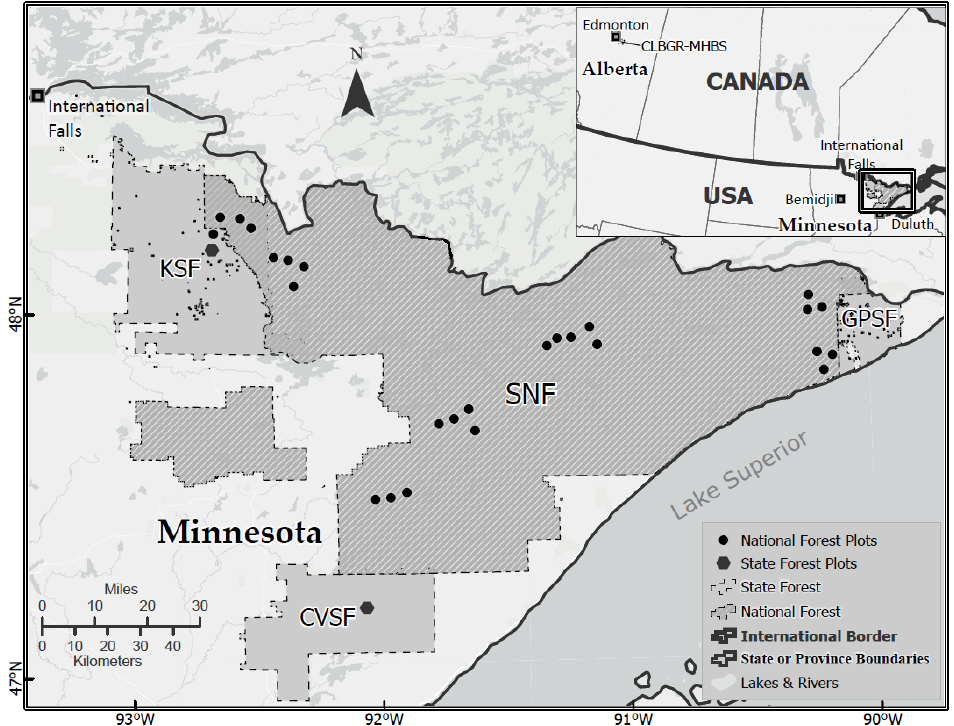
Figure 1. Study areas in Minnesota (Hodson 1977; inset + main map) and Alberta (Roland 2005; inset only). The National Forest sample sites (dots) indicate the clustered tree-ring sample locations underpinning the seven FTC outbreak chronologies in Minnesota of Robert et al. (2020). The two State Forest sample sites (octagons) identify locations for the KSF and CVSF chronologies of Cooke et al. (2003). SNF is the Superior National Forest. KSF, CVSF, GPSF are the Kabetogama, Cloquet Valley and Grand Portage State Forests of Minnesota. “CLBGR-MHBS” for the Cooking Lake Blackfoot Grazing Reserve and Ministik Hills Bird Sanctuary of Alberta.